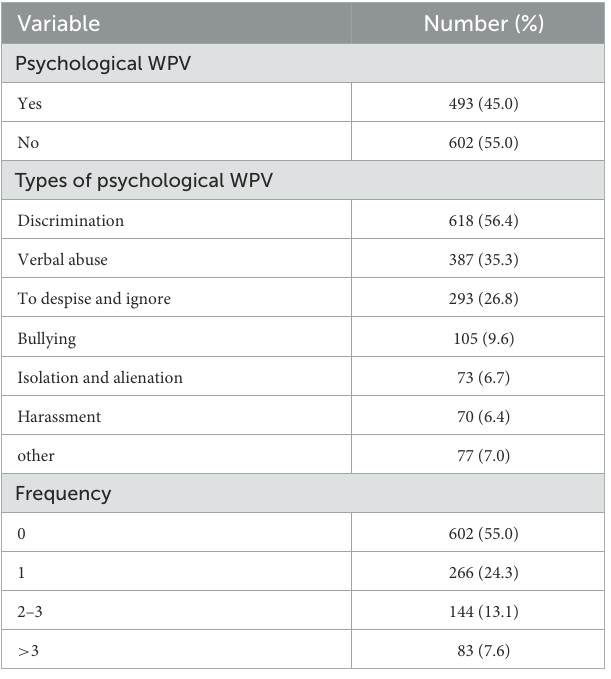
TABLE 2 Incidence rate of psychological WPV ( N =